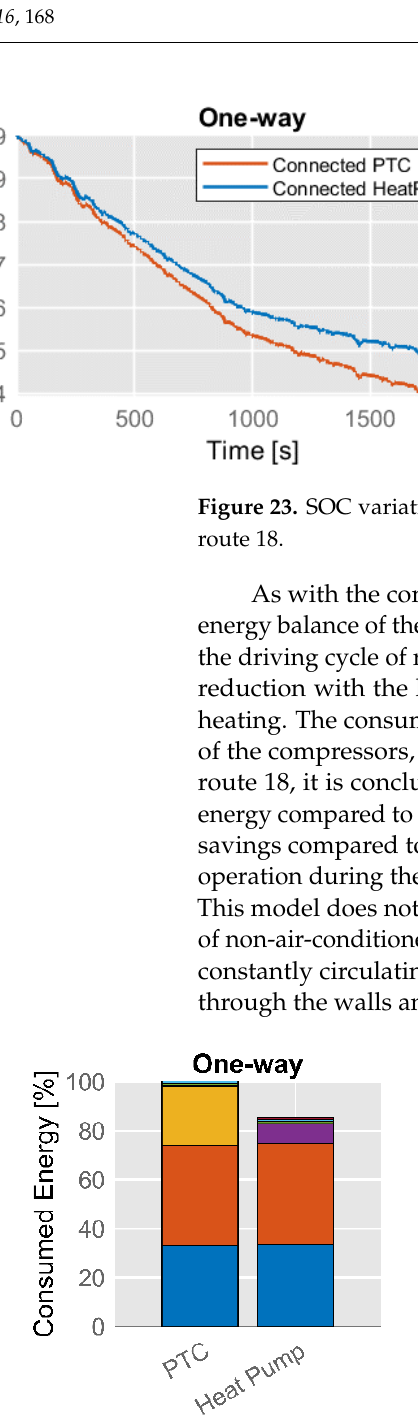
Figure 24. Global energy balance of the electric bus for both cabin heater systems.